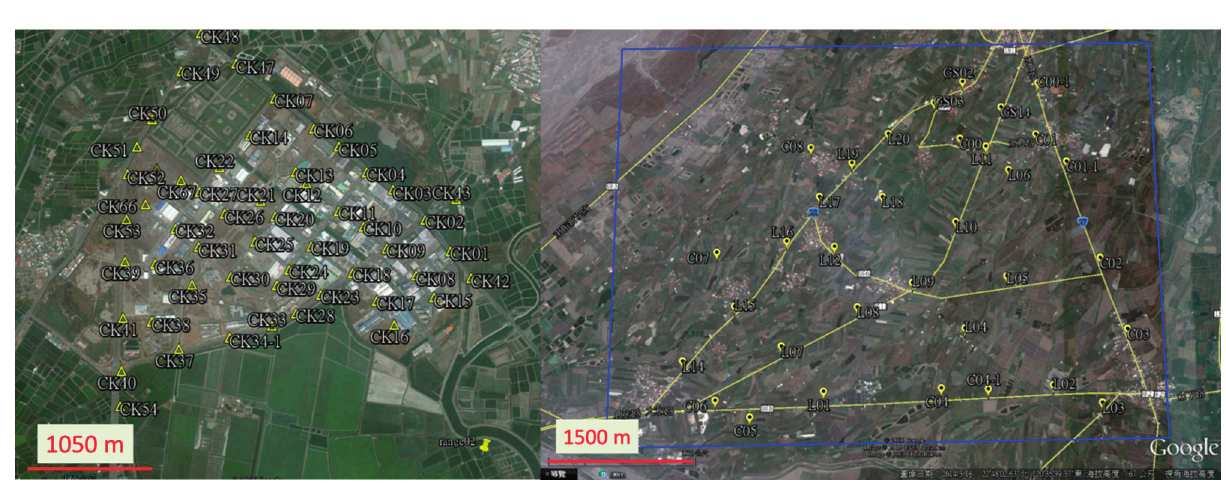
Figure 13. The distribution of GCPs in two control